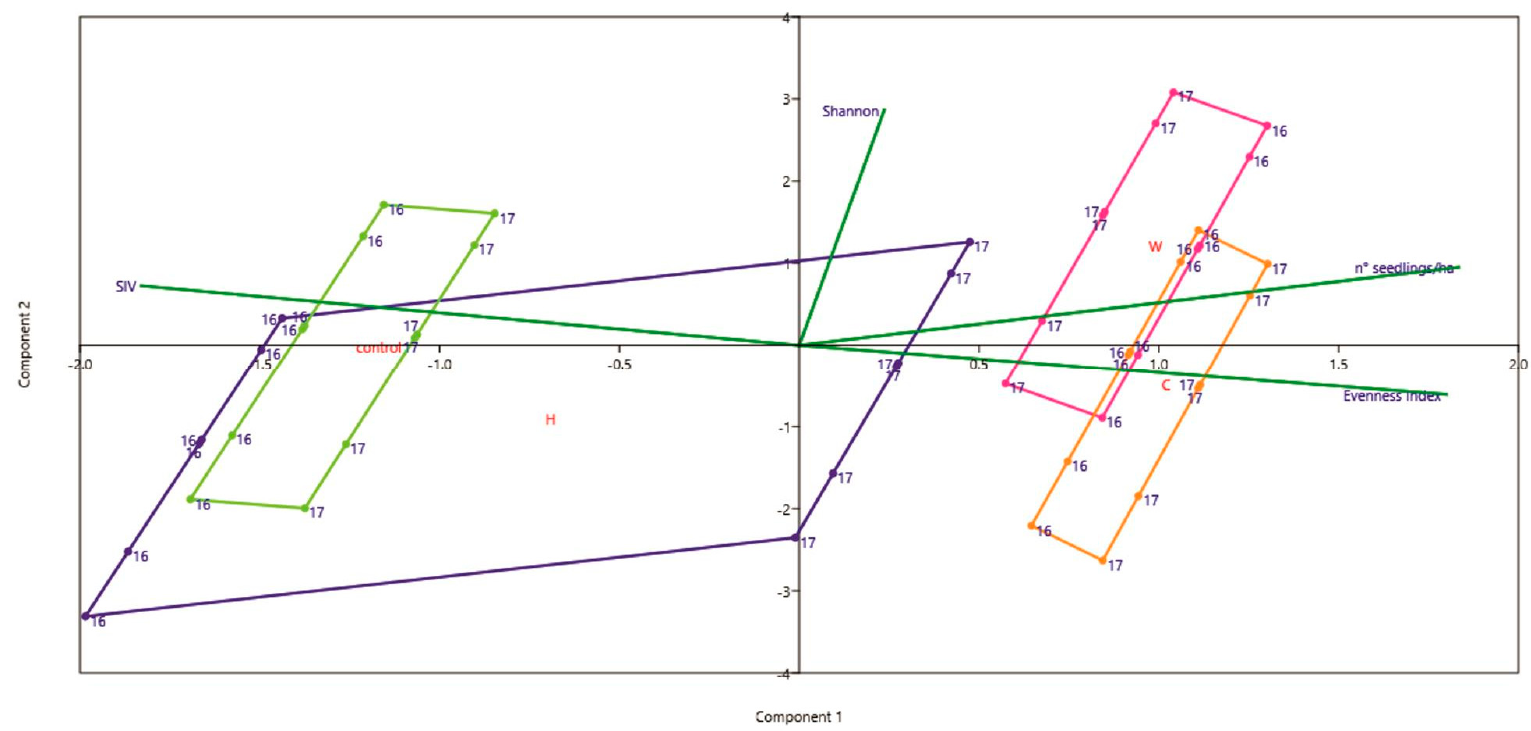
Figure 9. Score plot of the components PC1 and PC2 of the principal component analysis referred to tree regeneration situations. C (orange): strips harvested by cable yarder; W (pink): strips harvested by winch; H (violet): strips harvested by horse; Control (green): stand not harvested. The numbers 16 and 17 represent the years 2016 and 2017 respectively.